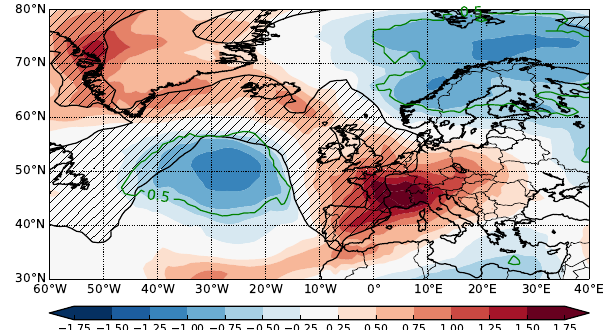
Figure 2. Anomaly of vertically averaged (500–150hPa) PV calculated as the deviation of the time averaged field between 16 May 2013, 00:00UTC and 31 May 2013, 00:00UTC from the 1979 to 2010 ERA-Interim May climatology (shaded every 0.25PVU). The hatching shows the regions with standard devia- tion of the 6-hourly PV-anomalies during these 15 days exceeding 0.75PVU, and the green contour the region with blocking frequency larger than 50% during the same